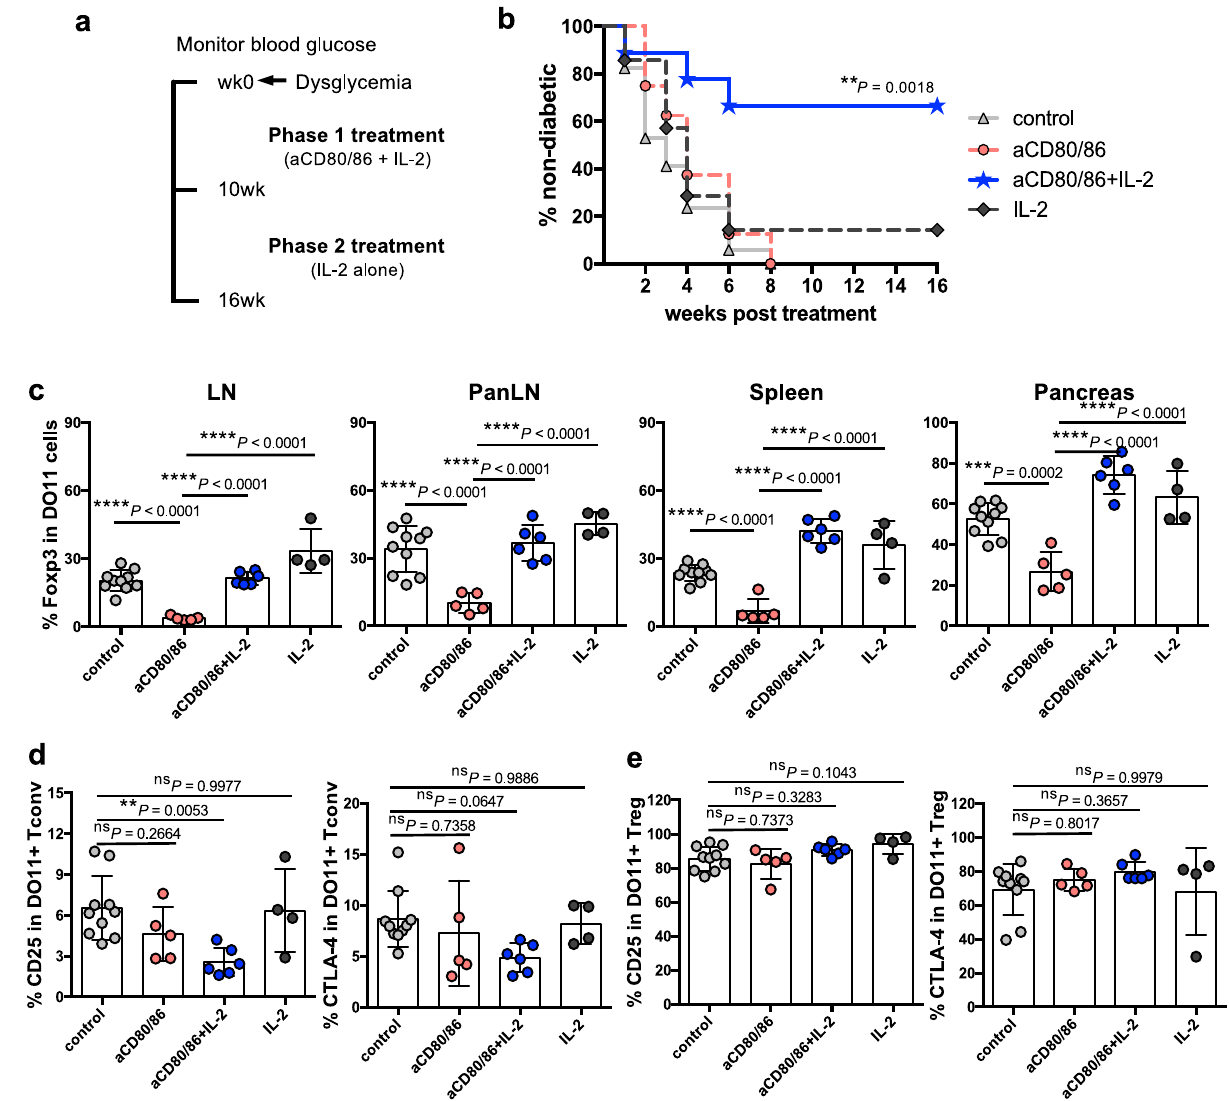
Fig.5|ImpactofcostimulationblockadeandIL-2ondiabetesdevelopmentina therapeutic setting. a Schematic of treatment protocol. Blood glucose levels of DO11×RIPmOVA mice were tracked, and animals with values falling between 180mg/dL and 290mg/dL were identi fi ed for treatment (see also Supplementary Fig. 4). Mice were injected i.p. with control Ab, anti-CD80/86 Ab, IL-2 complex or both anti-CD80/86 Ab and IL-2 complex. Anti-CD80/86 Ab was given 2 doses per week for total 10 weeks; IL-2 complex was administered in 3 doses for the fi rst week and then 2 doses per week. b Percentage of non-diabetic mice based on blood glucose measurements; n =17 for control, n =8 for aCD80/86, n =10 for aCD80/86+IL-2, n =8 for IL-2. Data are collated from 3 independent experiments. Diabetes incidence in the anti-CD80/86 Ab plus IL-2 complex group, but not